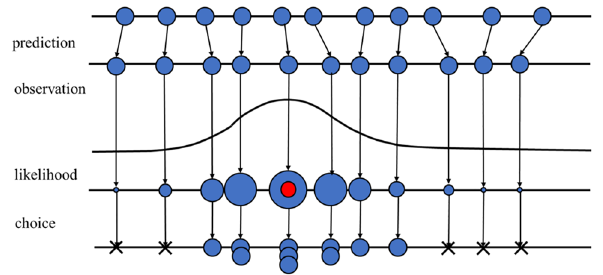
Figure 8. Particle filter algorithm. The particle filter enables robust tracking against noise and environmental